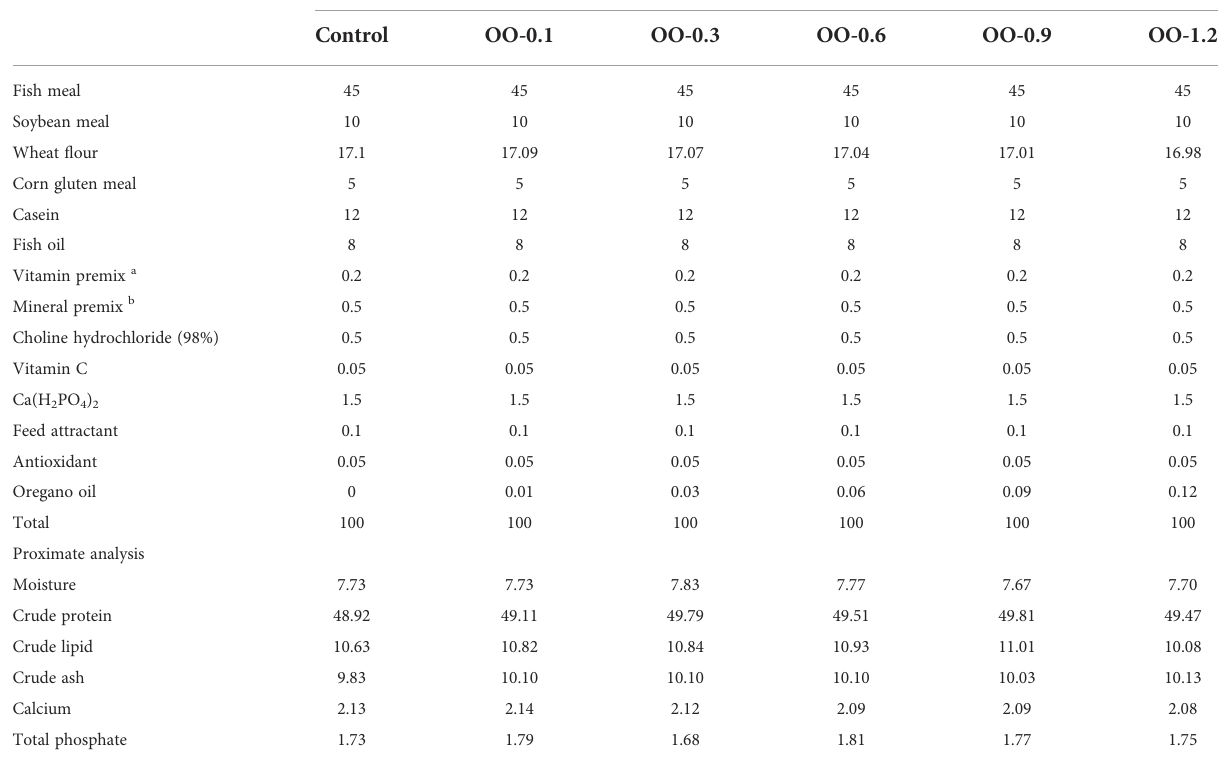
TABLE 1 Formulation and proximate compositions of the experimental diets (%